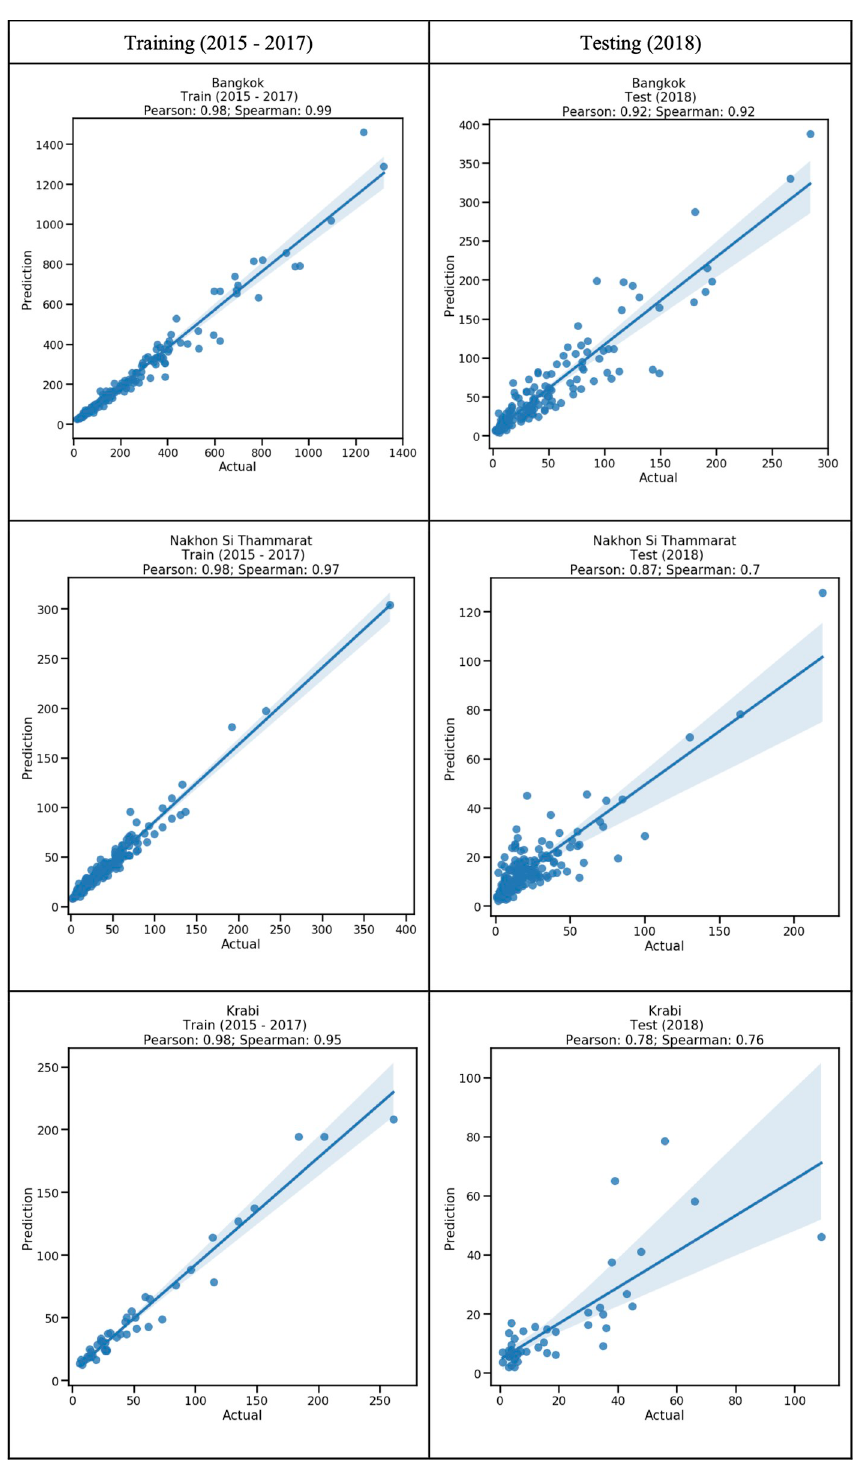
Fig 5. Scatter plots of predicted vs actual values of dengue incidence for LMER+C models for Bangkok, Nakhon Si Thammarat, and Krabi province for the training (2015–2017) and testing (2018) data. The maximum p-value of all panels is less than 2.384x10 -10 . The solid line is a linear trend line which is an indication of the linear (Pearson) correlation between the two variables. (Note: shading shows the 99% confidence interval).